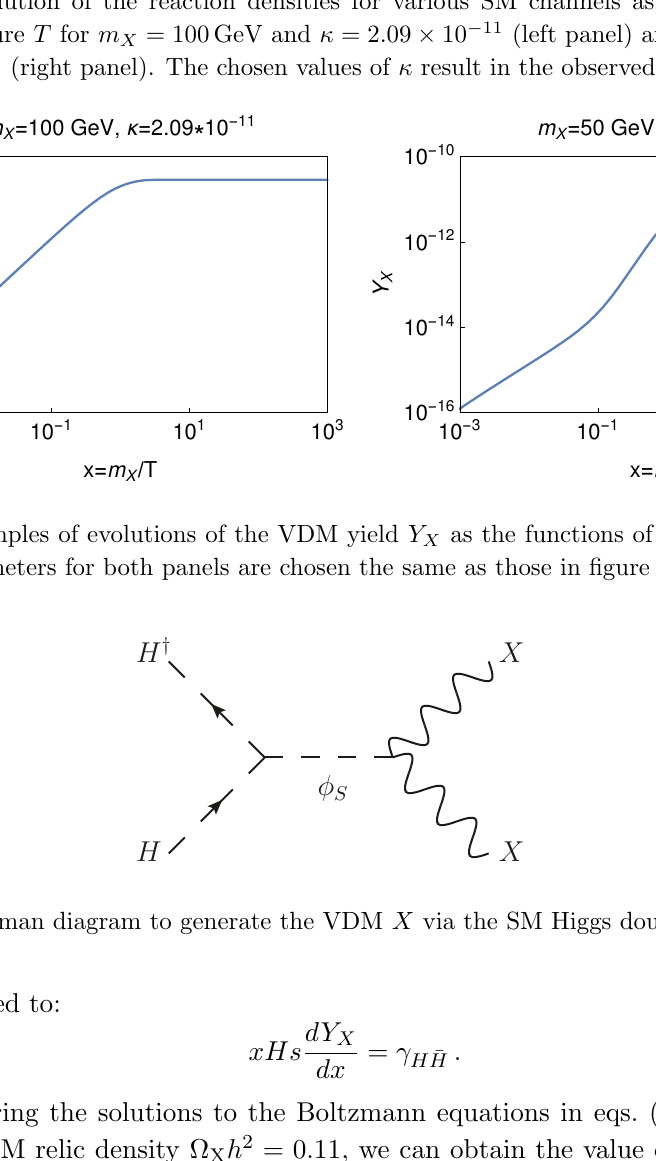
10 (cid:0) 11 (left panel) and m X = 50 GeV and (cid:2)